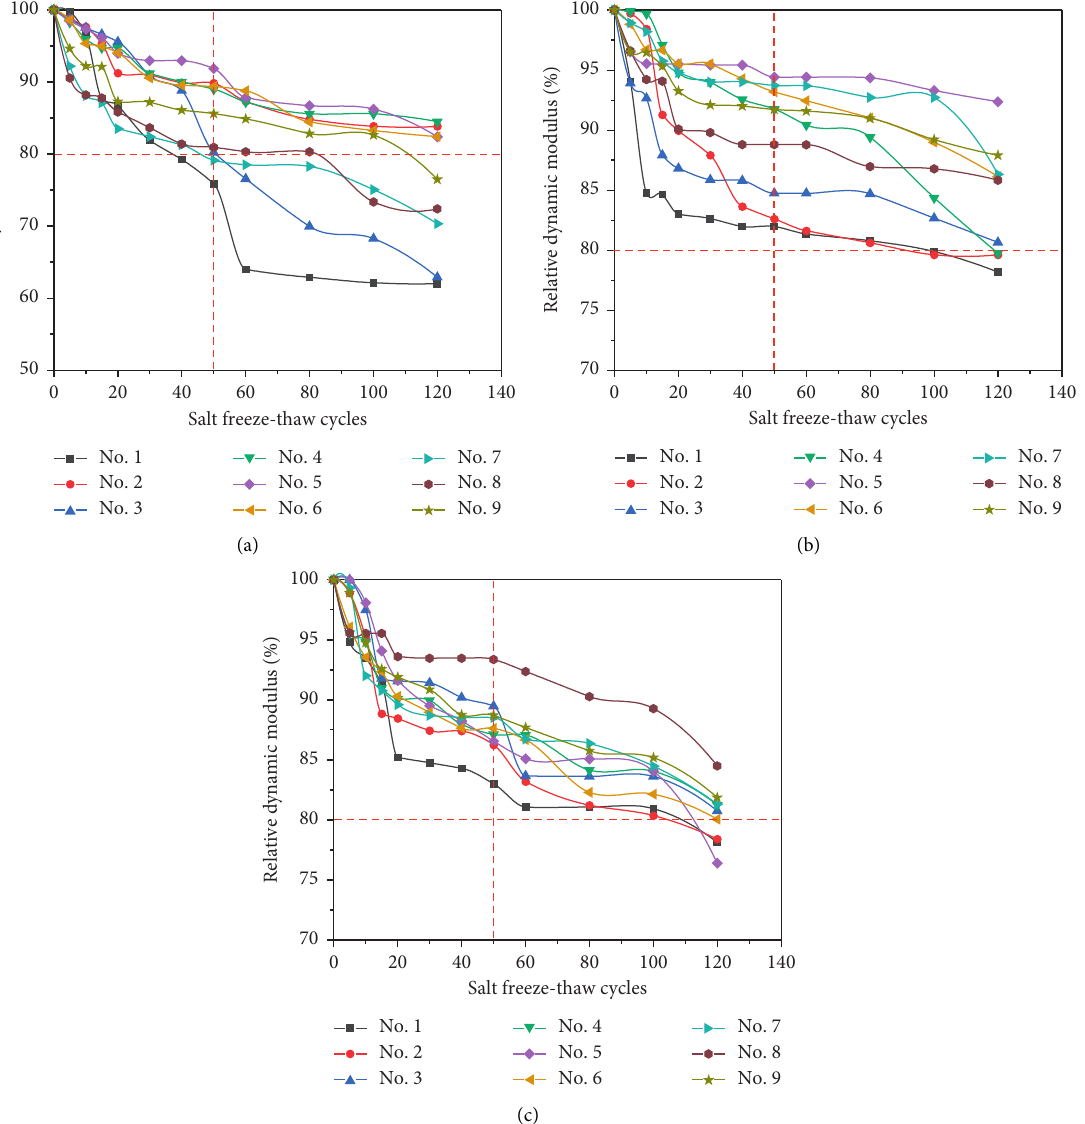
Figure 10: Relative dynamic modulus of concrete with triple-admixtures versus salt freeze-thaw cycles. (a) Air content of (2.5 ± 0.5)%. (b) Air content of (4.5 ± 0.5)%. (c) Air content of (6.5 ±